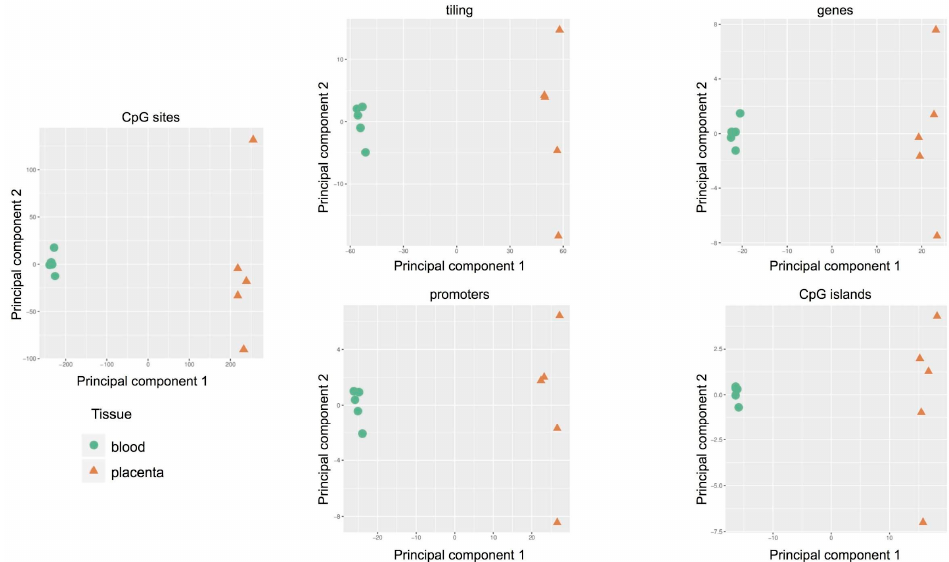
Figure 5. Targeted methylation sequencing: Principal Component Analysis (PCA) in five pregnancies (cases 11–15). Scatter plot showing the samples’ coordinates on principal components based on methylation scores of CpG sites (left) and regions (right): tiling, genes, promoters, and CpG islands.